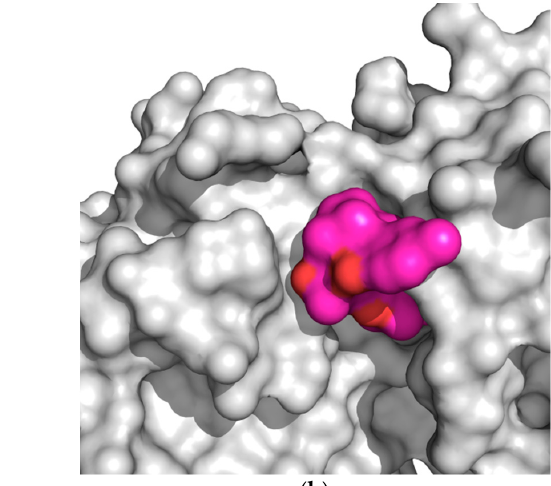
Figure 4. ( a ) Deeply bound and less exposed conformation of DeRoy ( 1 , cyan) in PKC (white); ( b ) more exposed bound conformation of RoyBzCl ( 5 , magenta) in PKC (white). All molecules in solvent-accessible surface area representation.